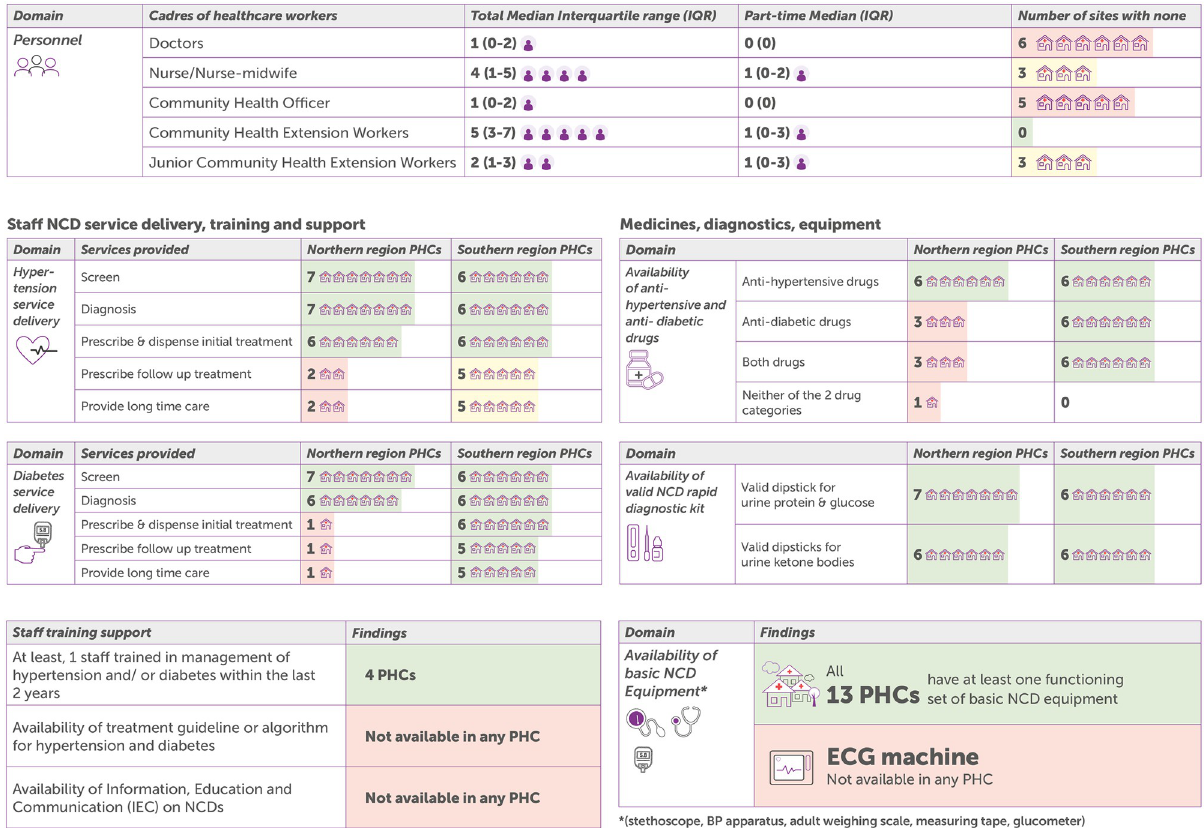
Fig 1. Summary of NCD-related SARA findings from all 13 PHCs